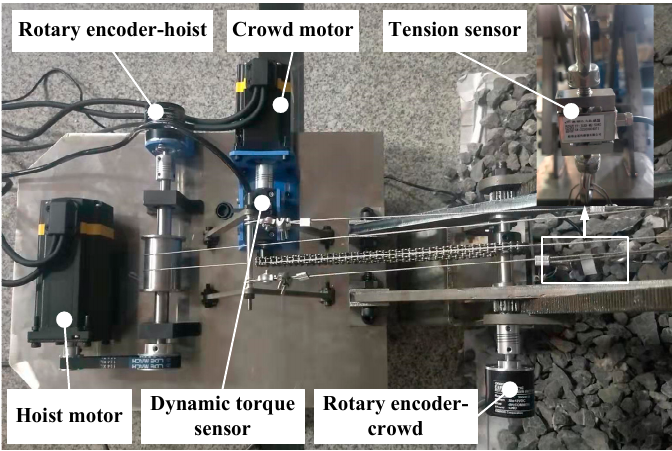
Figure 13. Electric shovel scale model test bench.